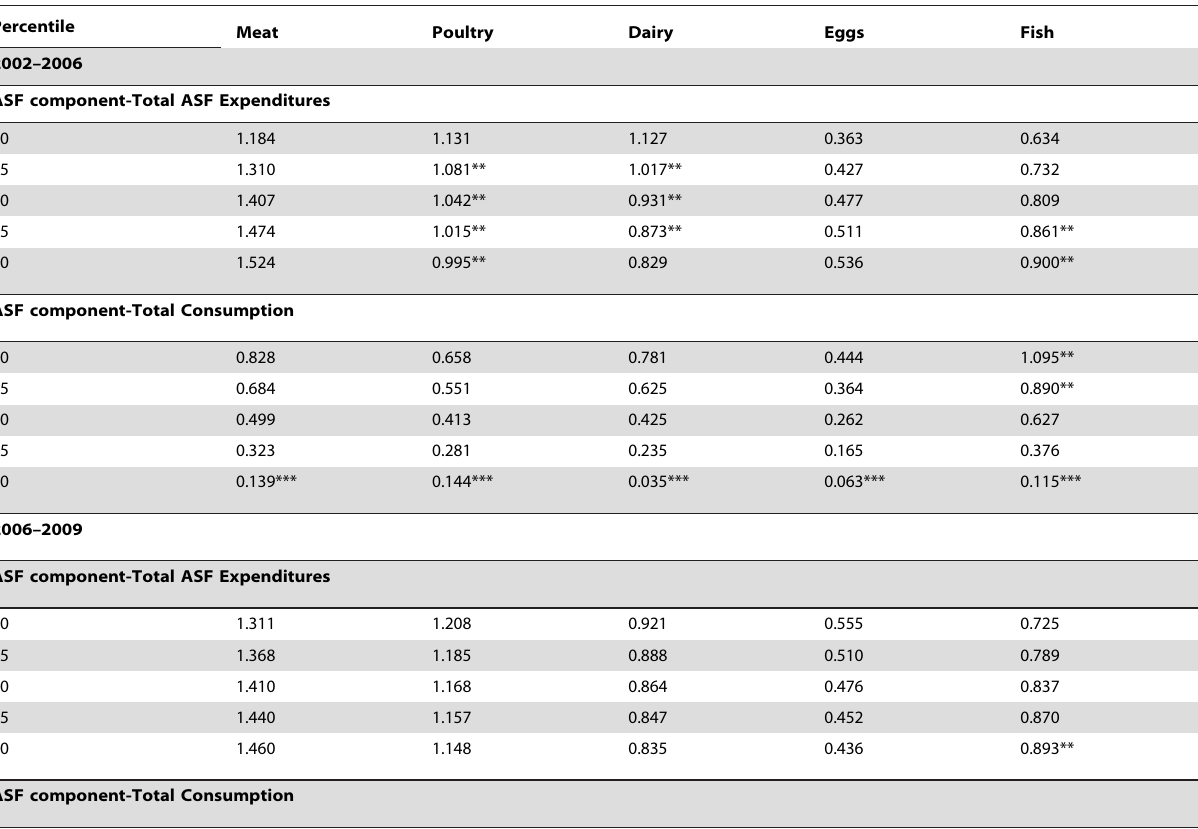
Percentile Meat Poultry Dairy Eggs